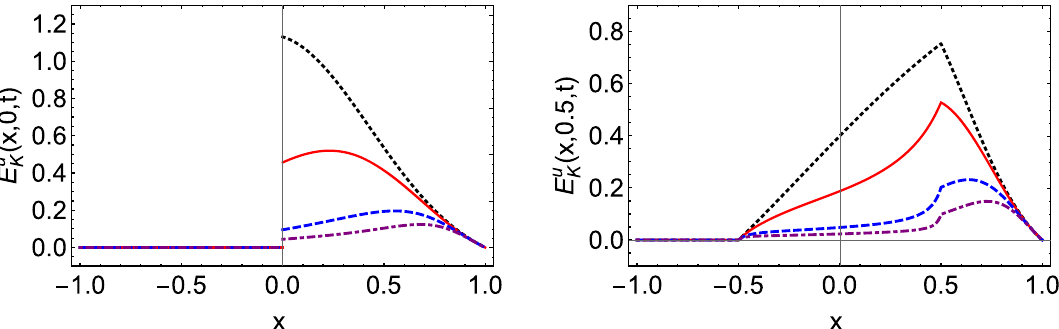
Fig. 6 Kaon u quark tensor GPDs (left panel: ξ = 0, right panel: ξ = 0 . 5) with different t : black dotted line – t = 0 GeV 2 , red line – t = − 1 GeV 2 , blue dashed line – t = − 5 GeV 2 , purple dotdashed line – t = − 10 GeV